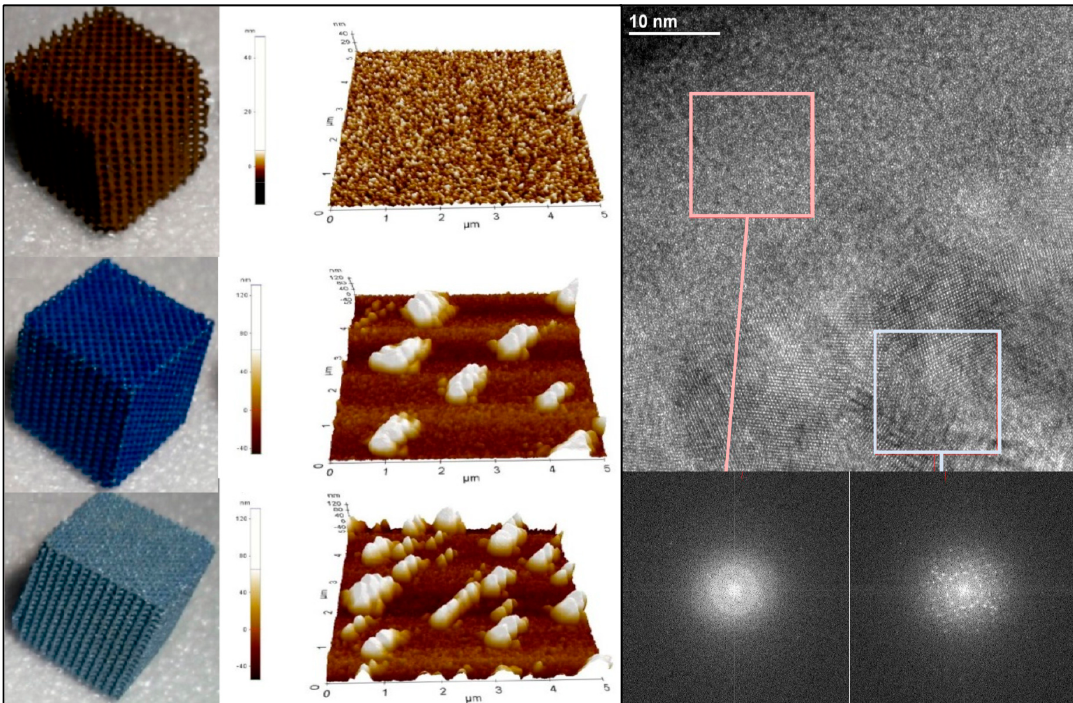
Figure 24. Examples of pure titanium porous samples manufactured by the selective laser sintering SLS method and coated with the atomic layers deposition ALD method inside the pores with a TiO 2 nano-layer; the first column - the models of fully porous implant-scaffolds with dimensions of 10 × 10 × 10 mm, made of pure titanium, coated in the ALD process with TiO2 nanolayers successively in 500, 1000 and 1500 cycles.; the middle column - the surface morphology of these samples observed in the Atomic Force Microscope AFM corresponding to these thicknesses; the last column - Fast Fourier Transform FFT of pure titanium sample film coated with a TiO 2 layer for 1500 cycles tested in a high-resolution transmission electron microscope HRTEM confirming the crystalline Ti substrate structure (pink) and amorphous structure of TiO 2 layer